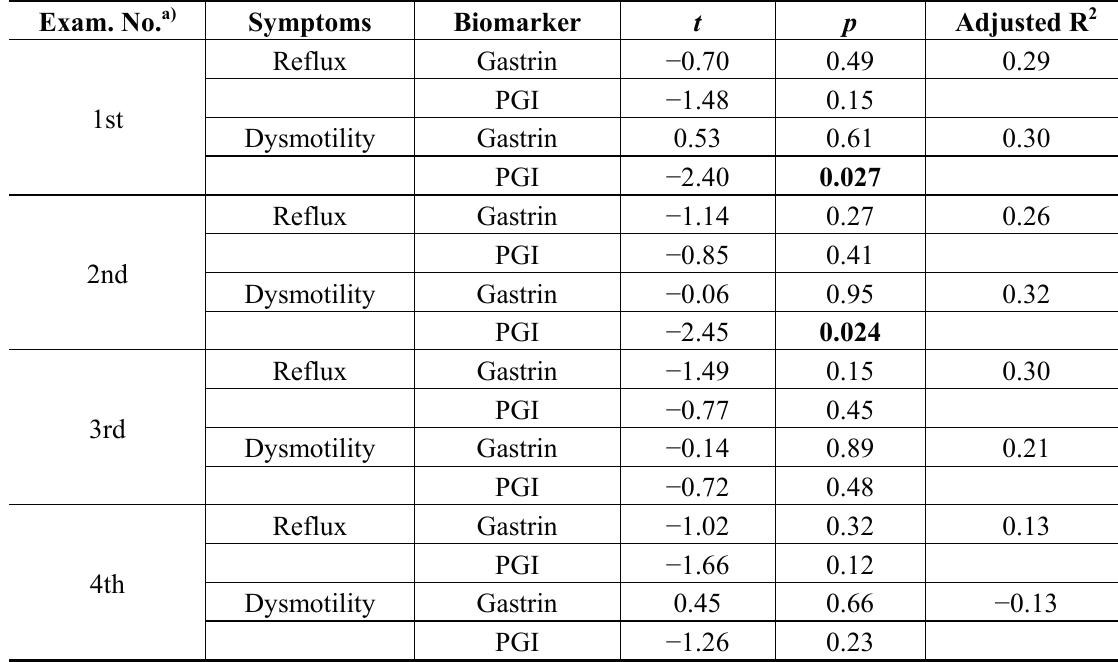
Table 3. Associations between upper GI symptoms and biomarkers at each time point; sex and age adjusted.